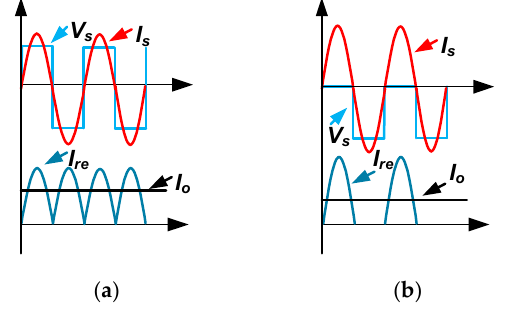
Figure 8. Typical waveforms of the Rx under different duty ratios ( a ) d Qs = 0; ( b ) d Qs = 1.